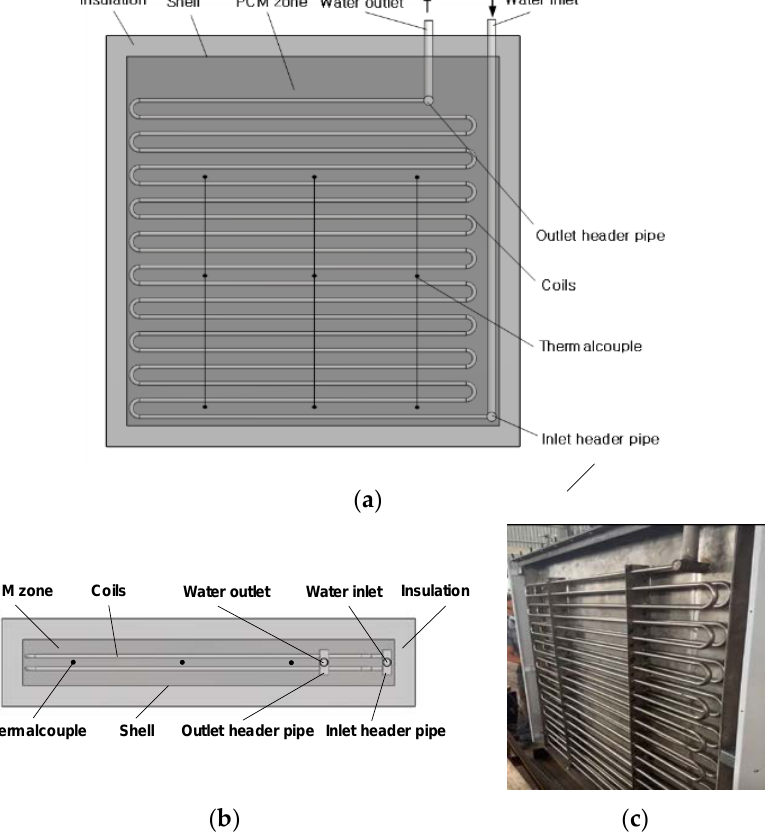
Figure 3. Heat storage device for MNH90 test: ( a ) plane section diagram, ( b ) vertical view, and ( c ) internal structure of heat storage.